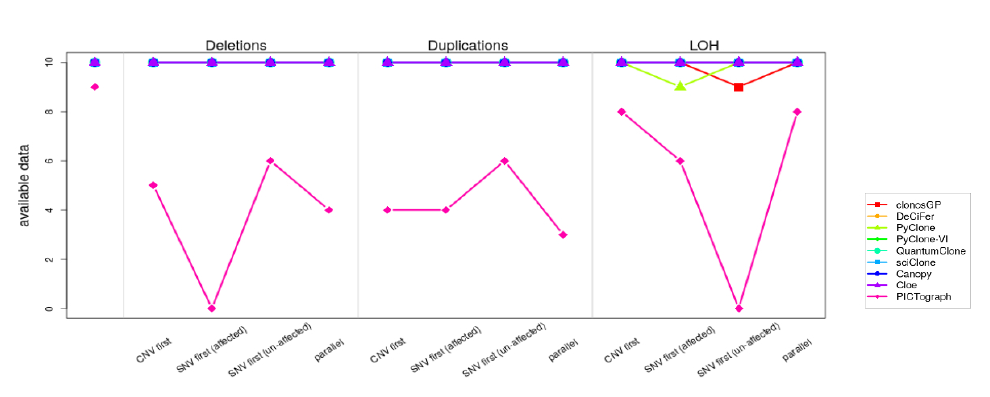
Figure A12. Available clustering output generated using clonosGP, DeCiFer, PyClone, PyClone- VI, QuantumClone, sciClone, Canopy, Cloe, and PICTograph in the presence of CNVs. For each considered number of time points, clones, variants, and coverage, 10 patients were simulated.